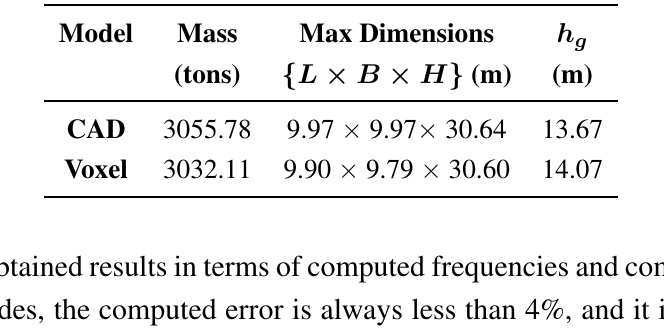
Table 2. Mass, overall dimensions and center of mass